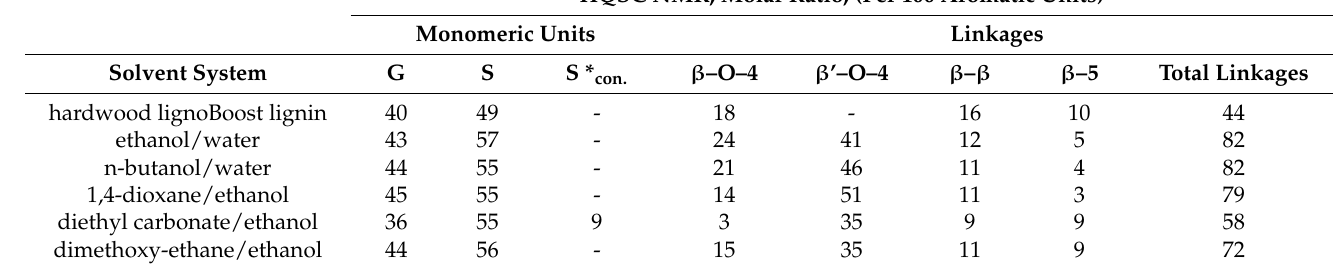
Table 4. Lignin-enriched fraction monolignols and dominant linkage distribution as determined by semi-quantitative 2D HSQC NMR